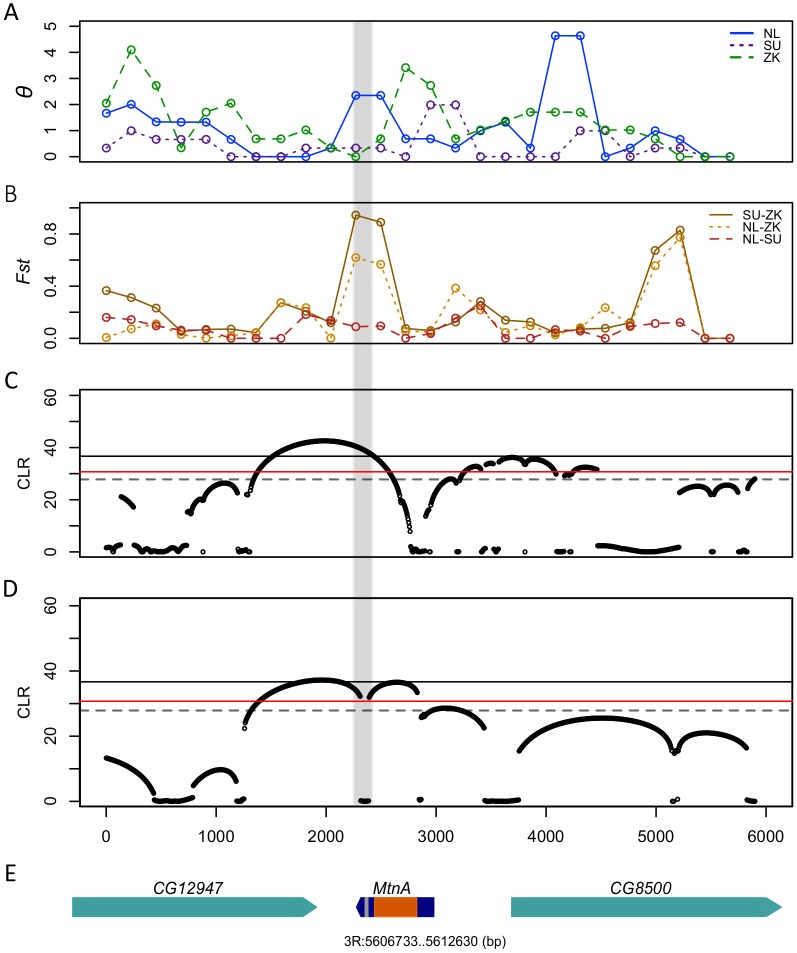
Evidence for positive selection at the MtnA locus.(A) Watterson’s θ of D. melanogaster populations from Zimbabwe (ZK), the Netherlands (NL) and Sweden (SU) calculated in sliding windows of 500 bp with a step size of 250 bp. (B) Fst values for pairwise comparisons of ZK, NL and SU calculated in sliding windows of 500 bp with a step size of 250 bp. (C) Selective sweep (SweepFinder) analysis of the Netherlands population showing the composite likelihood ratio (CLR) statistic in sliding windows of 1000 bp. (D) Selective sweep (SweepFinder) analysis of the Swedish population showing the CLR statistic in sliding windows of 1000 bp. The black line indicates the 5% significance threshold calculated using the demographic model of Duchen et al. [5] for neutral simulations. The red line indicates the 5% significance threshold calculated using the demographic model of Werzner et al. [6] for neutral simulations and the gray dashed line indicates the 5% significance threshold using the model of Thornton and Andolfatto [35]. (E) Gene models for the 6-kb region analyzed. The gray highlighted region indicates the position of the 49-bp indel polymorphism in the MtnA 3’ UTR.